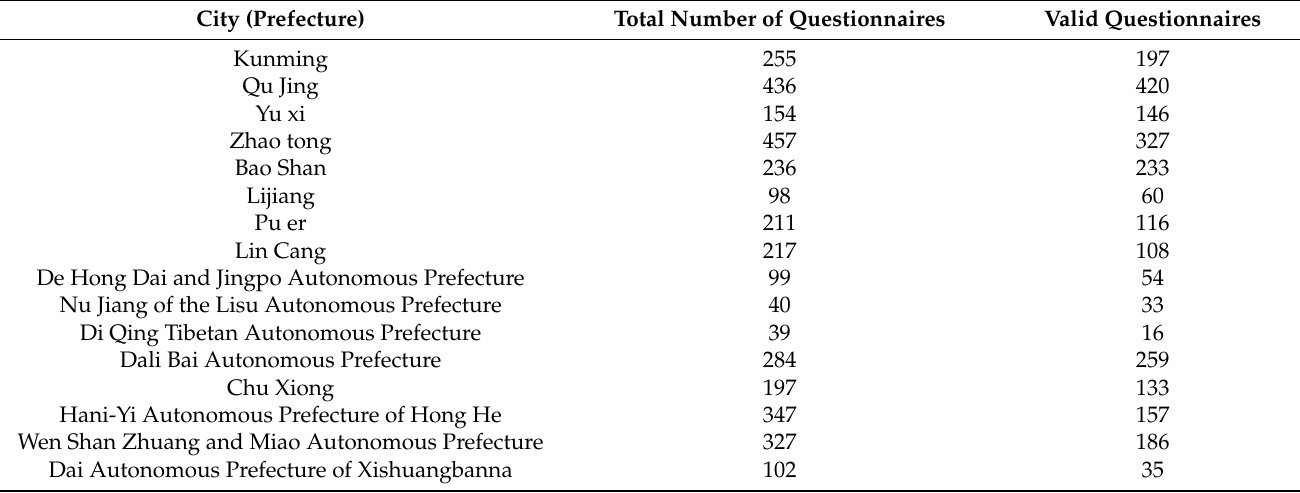
Table 1. Distribution of questionnaires.